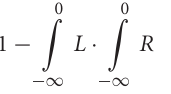
the panel. (B) Similar but for call intensity. (C,D) Two spectrograms of call sequences of Rhinolophus formosae . (C) calls of a perched bat. The frequency modulated parts (FM 1 and FM 2 ) of one of the calls are indicated. (D) calls of a perched bat taking off. Only the strongest first overtone is shown in this